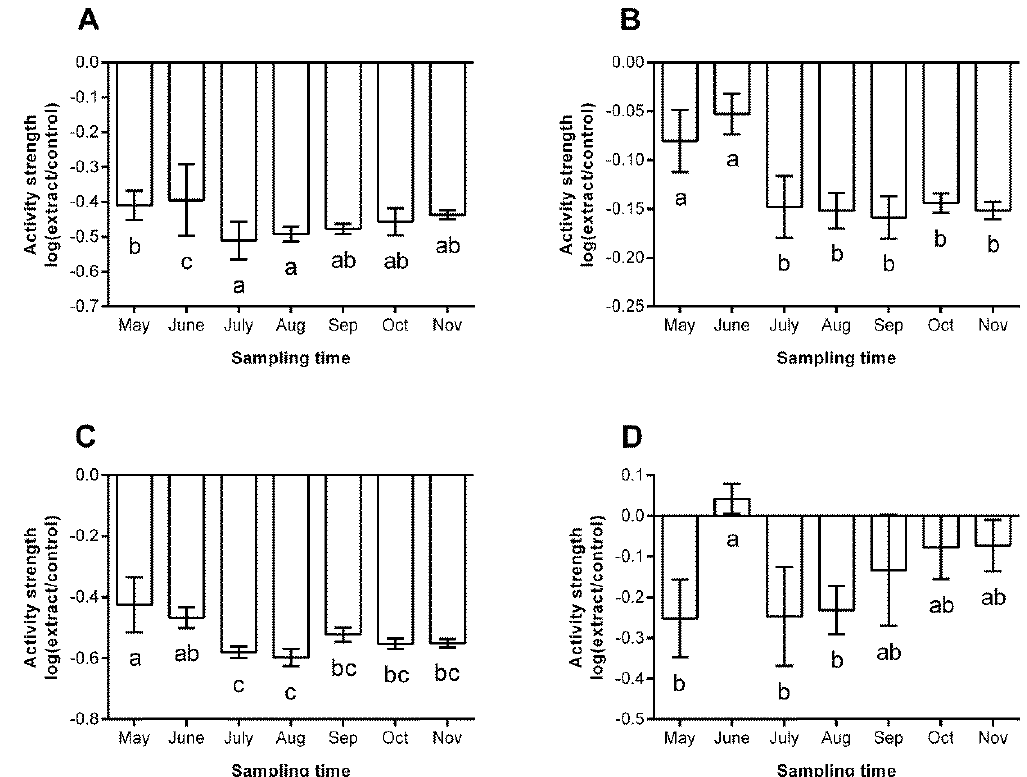
Figure 2. Seasonal variation of the antisettlement activity of propan-2-ol surface extract from Z. marina against ( A ) B. aquimaris ; ( B ) A. stellipolaris ; ( C ) L. rosea , and ( D ): P. dokdonensis (mean ± SD, n = 4). Increasingly negative values indicate increasing activity strength, positive values indicate attraction. Months that are significantly different (Tukey’s post hoc test, p < 0.05) are marked by different letters.